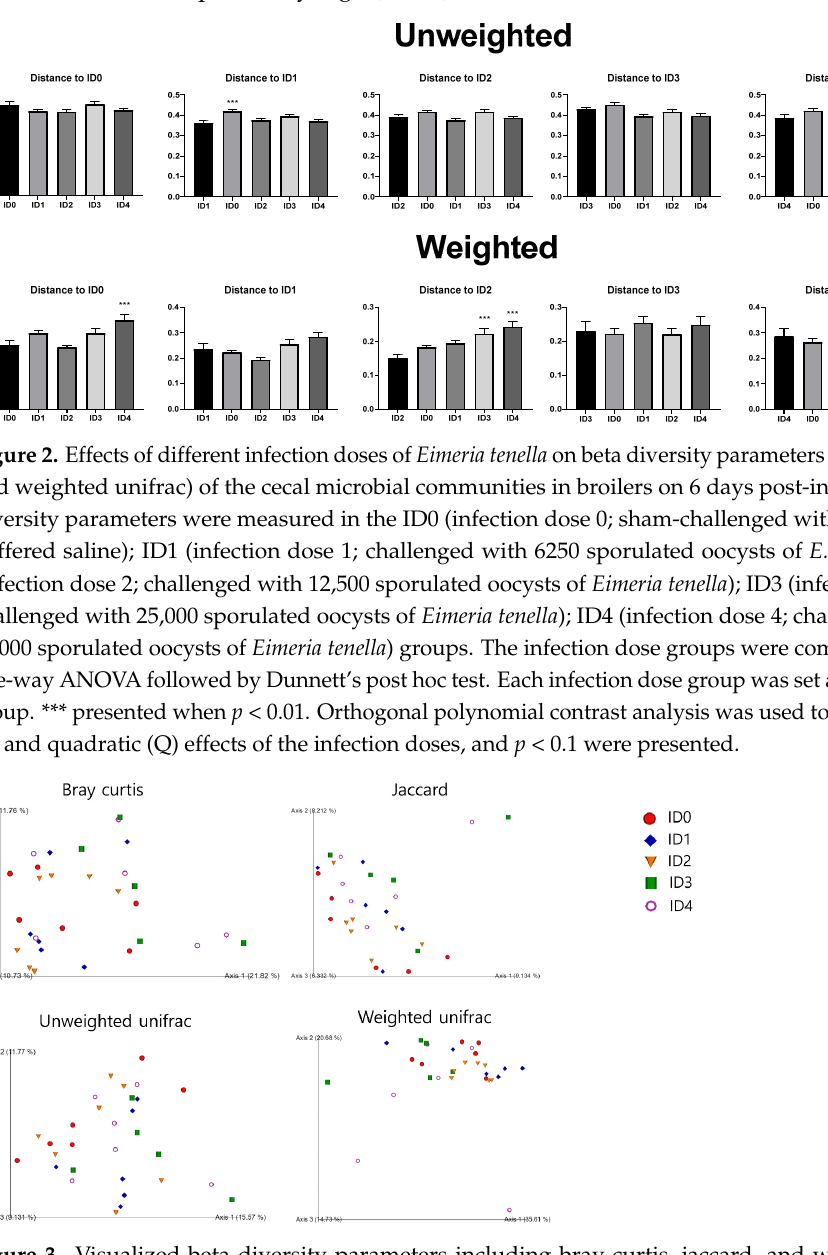
Figure 3. Visualized beta diversity parameters including bray curtis, jaccard, and weighted and unweighted unifrac in the Eimeria tenella infected broiler groups 6 days post-infection: ID0 (infection dose 0; sham-challenged with phosphate-buffered saline); ID1 (infection dose 1; challenged with 6250 sporulated oocysts of Eimeria tenella ); ID2 (infection dose 2; challenged with 12,500 sporulated oocysts of E. tenella ); ID3 (infection dose 3; challenged with 25,000 sporulated oocysts of E. tenella ); ID4 (infection dose 4; challenged with 50,000 sporulated oocysts of Eimeria tenella